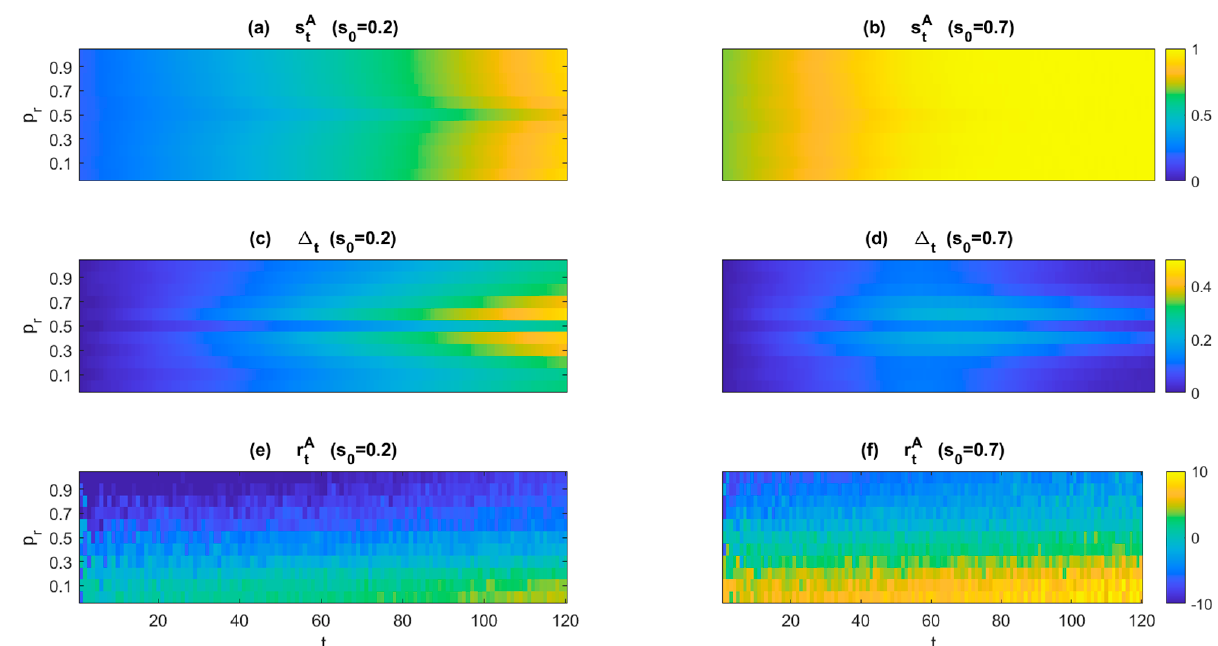
Figure 2. Comparison between aware (A) and habitual (H) states and rewards over time, for individuals with different levels of reasoning propensities p r . The color bar reports the different variables of interest. For the two upper panels ( a , b ) the color bar indicates the level of the state, for the two middle panels ( c , d ) the payoff obtained by applying an aware policy with respect to the habitual − s H one, where ∆ t = s A , and in the two bottom panels ( e , f ) the reward for an aware policy. All the panels on the left consider a low initial state ( s 0 = 0.2) while the ones on the right consider a high initial level ( s 0 = 0.7). The aware model’s parameters used for the comparison are fixed to α = 1, β = 1.5, γ = [ 5, 1, 0.01 ] , and δ = 0.75. The functions used to perform the simulations are described in detail in Appendix